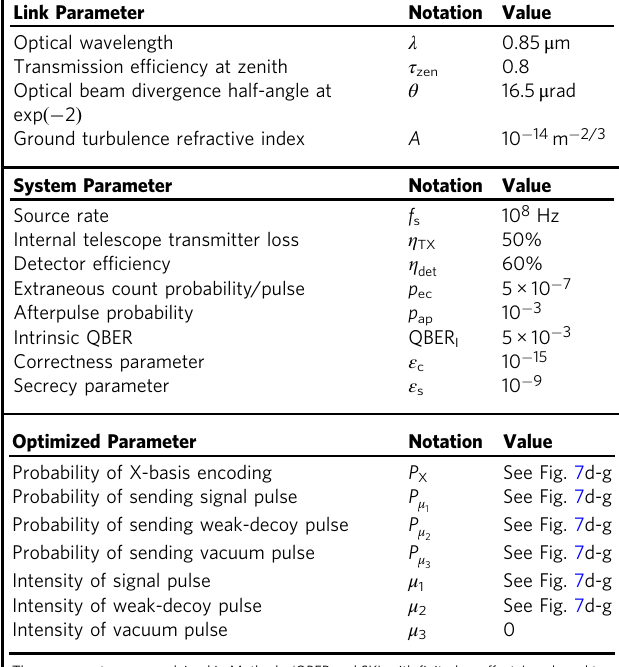
Table 2 Decoy-state ef fi cient Bennett-Brassard 1984 quantum key distribution